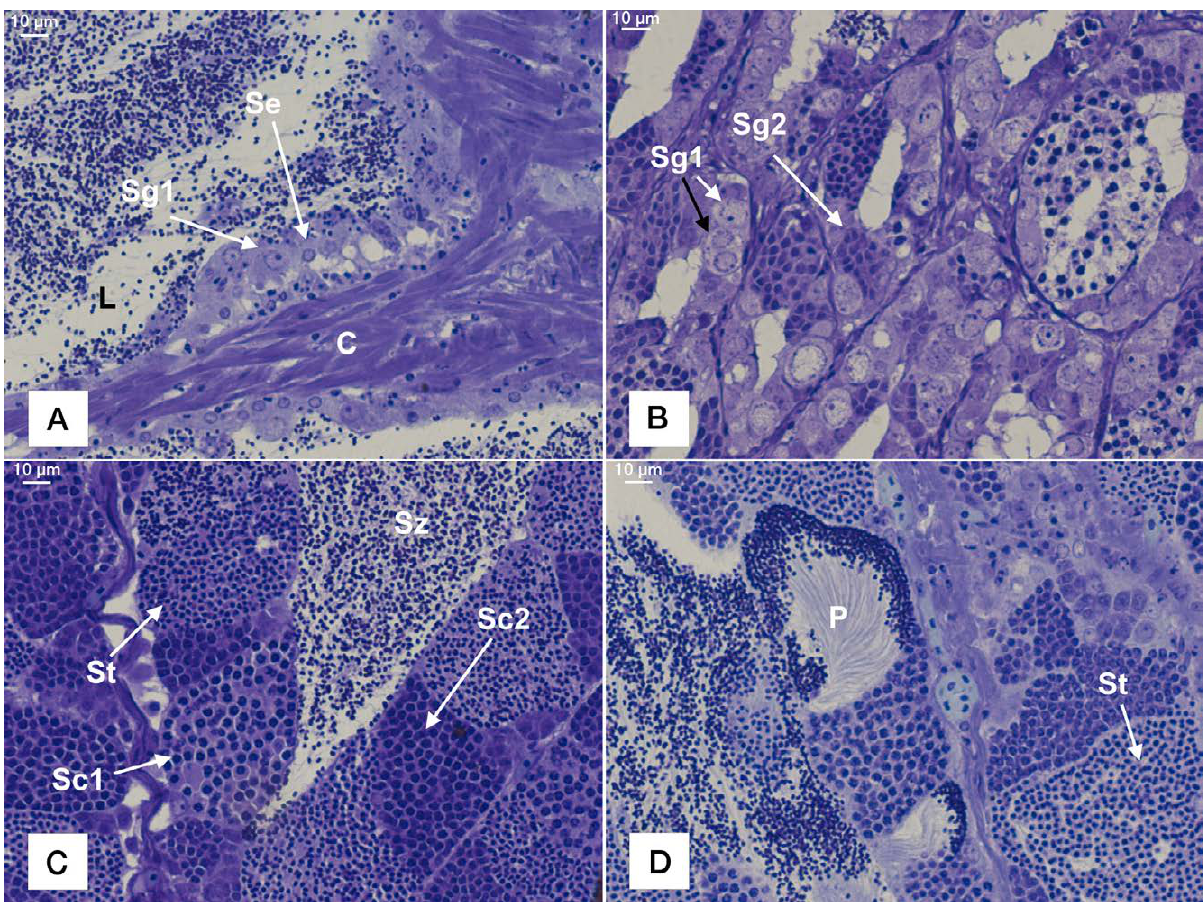
Fig. 4. – Histological stages of meagre spermatogenesis. A, primary spermatogonia (Sg1); B, Sg1 and secondary spermatogonia (Sg2). Black arrow, Sg1 in mitotic division; C, primary (Sc1) and secondary (Sc2) spermatocytes, spermatids (St) and spermatozoa (Sz); D, bursting St in “Parachute” form (P). Connective tissue (C), Lobule lumen (L), Sertoli cell (Se). Scale bar, 10 μm, 400 ×